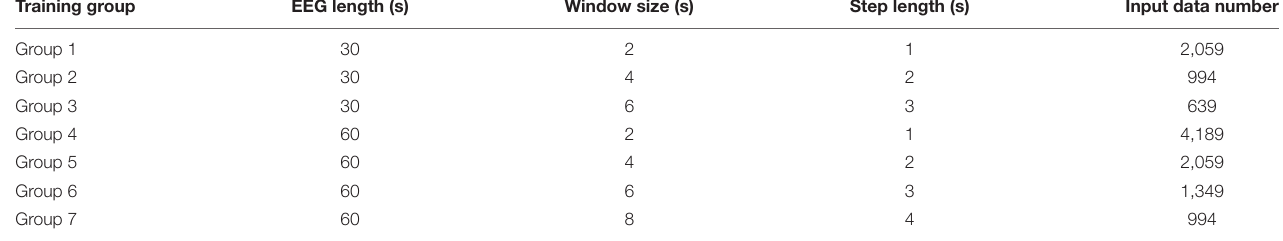
TABLE 3 | Input data groups.